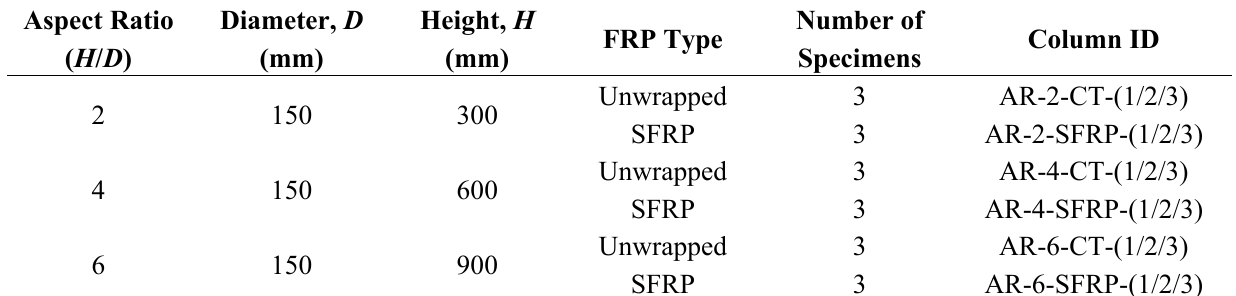
Table 2. Test matrix of the aspect ratio columns wrapped with SFRP sheets, along with their respective control specimens.